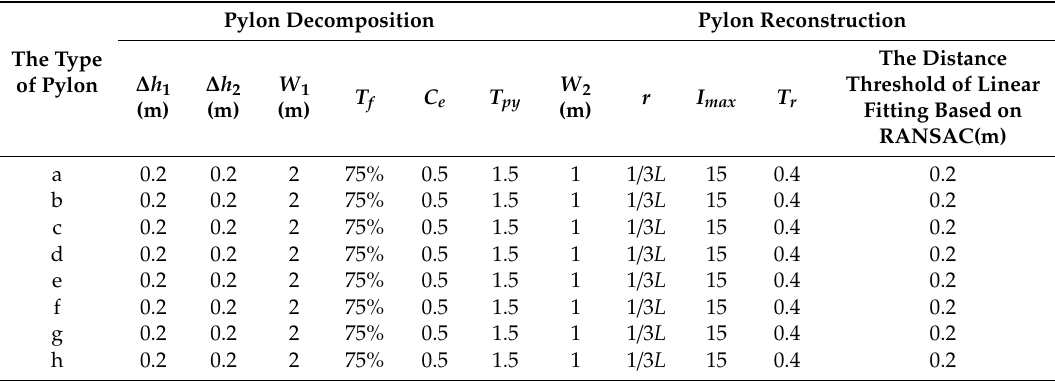
Table 7. The parameters of the proposed